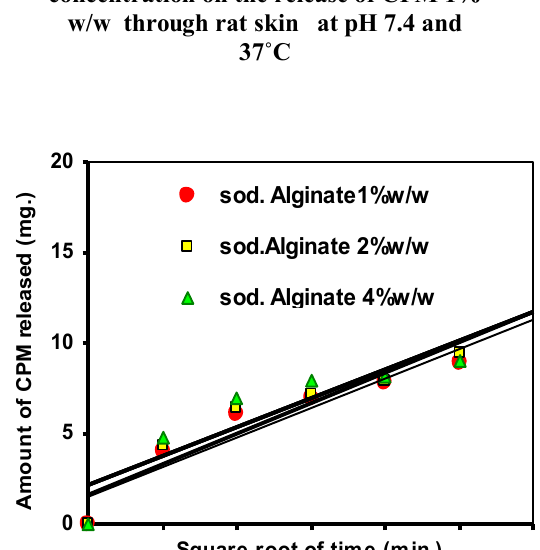
Figure (1) . The effect of different bases on the release of CPM 1%w/w at pH 7.4 and